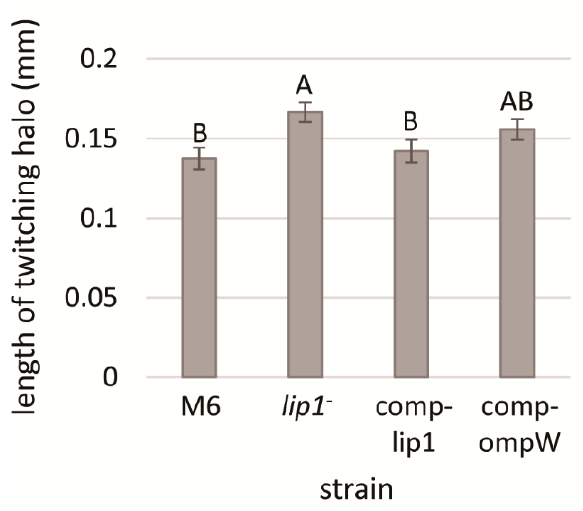
Figure 4. Length of twitching haloes of A. citrulli M6, the M6- lip1 - mutant, and M6- lip1 - carrying plasmid pBBR-MCS-5 expressing lip1 or ompW (M6-comp-lip1 and M6-comp-ompW, respectively). Bacteria were grown for 48 h on NA plates at 28 ◦ C, and twitching haloes around the colonies were measured from 30 colonies per strain. Data represent averages and standard errors (SE) from one experiment, out of three with similar results. Different letters indicate significant differences ( p < 0.05) among treatments by Tukey–Kramer and